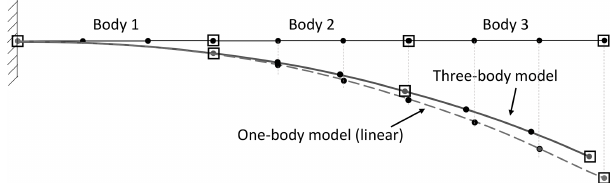
Figure 1. Structural modeling of a cantilever beam in floating ref- erence system with multiple bodies, in deflected and undeflected